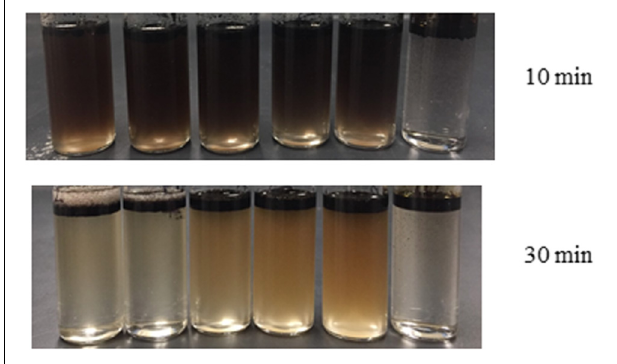
FIGURE 7 | Visualization of emulsion stability (from left to right, biosurfactant concentration increased from 0 to 100%). A series of co-surfactants